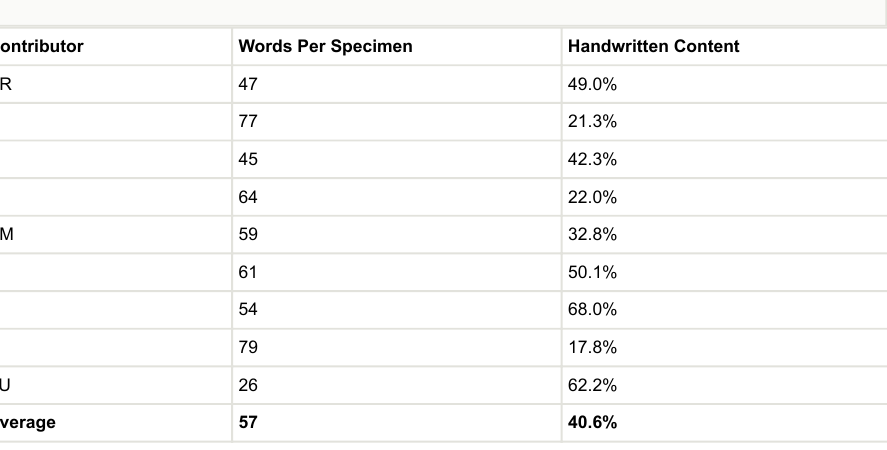
A summary of specimen properties. The Names and Index Herbariorum codes for the contributing herbaria are listed in Table